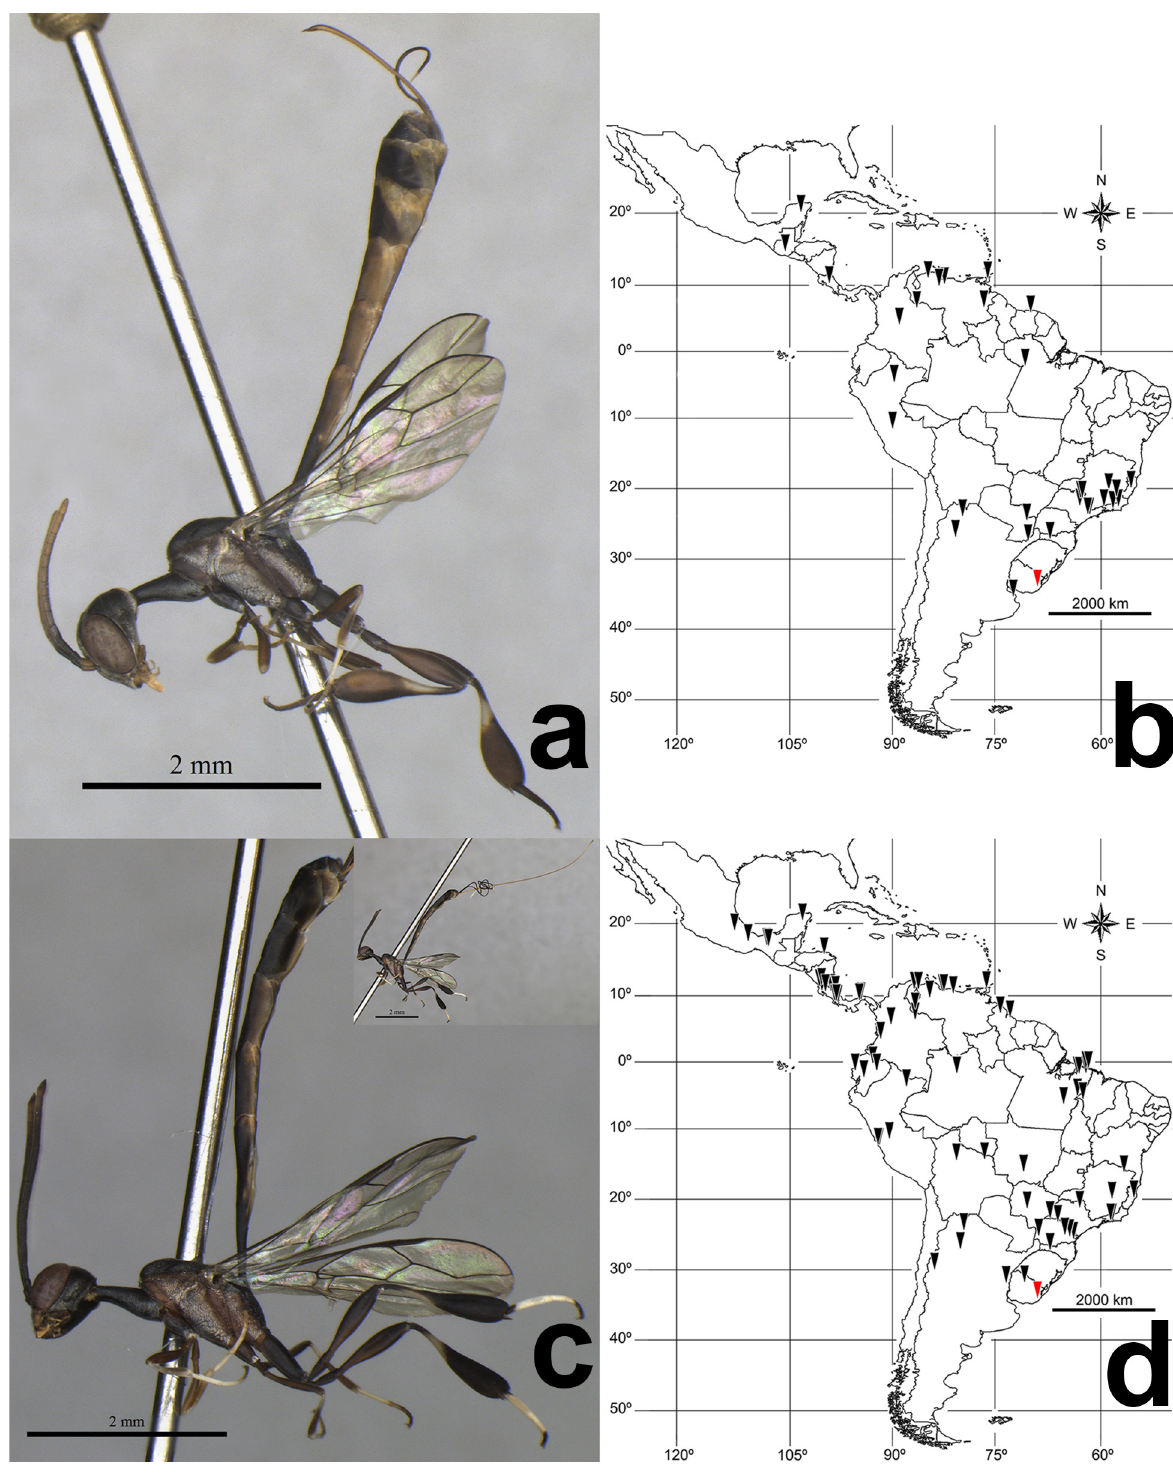
Figure 1. a. Gasteruption brachychaetum Schrottky, 1906, female, habitus lateral. b. Map of known distribution of Gasteruption brachychaetum Schrottky, 1906. c. Gasteruption brasiliense (Blanchard, 1840), female without ovipositor; in detail, habitus lateral. d. Map of known distribution of Gasteruption brasiliense (Blanchard, 1840). Black triangles are previous records (Macedo 2011), the red ones new records to